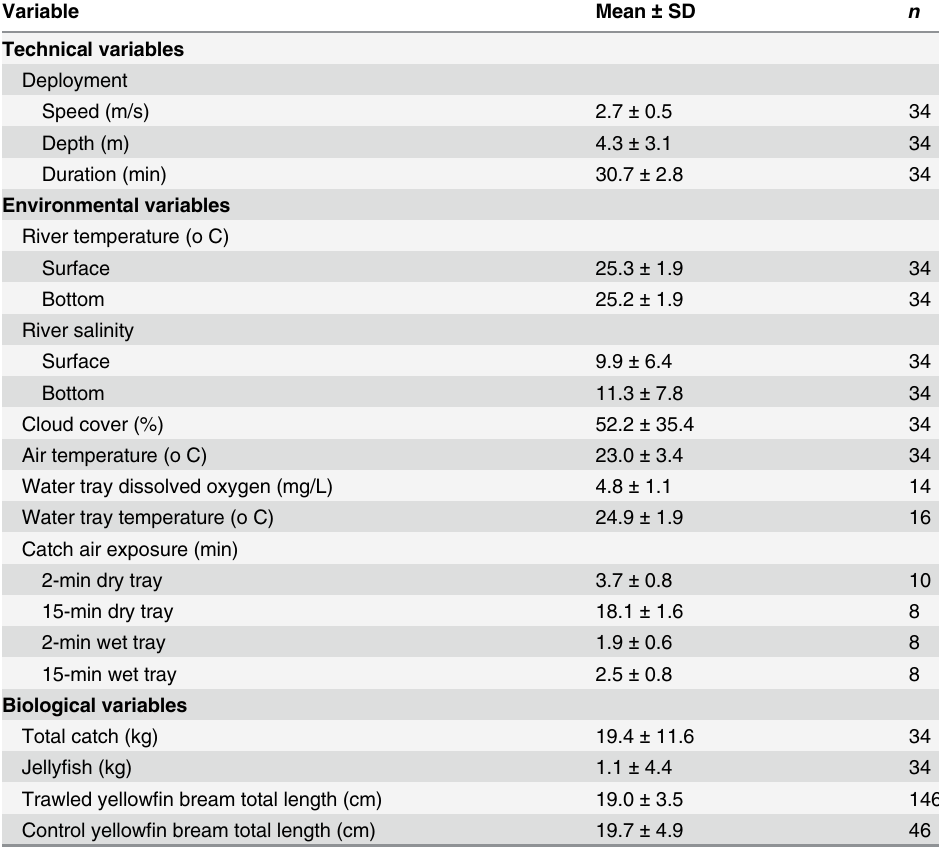
Table 2. Summary of Mean ( ± SD) key environmental, technical and biological variables collected dur- ing the deployments.